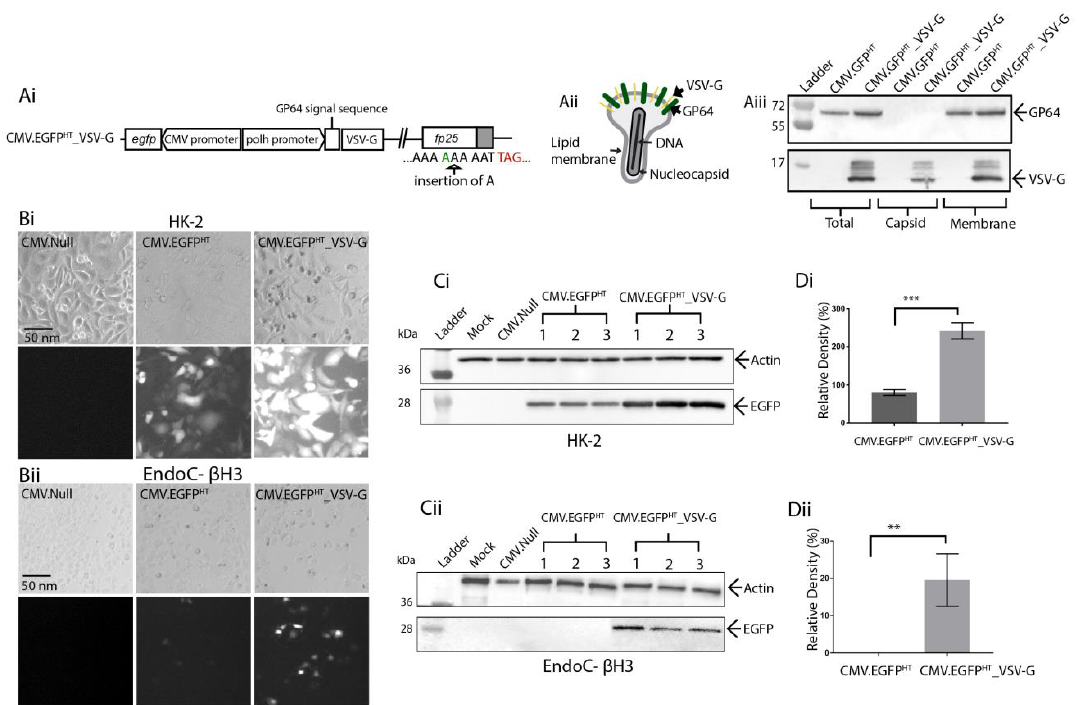
Figure 4. ( A ) schematic representation of the VSV-G pseudotyped BacMam vector construct. ( Ai ) 21-amino-acid ectodomain of VSV-G, with its transmembrane and cytoplasmic tail domains (aa 442–511) [29] was inserted into the HT virus genome under the control of the polh promoter as a fusion to the gp64 signal peptide. TAG, stop codon (red) ( Aii ) Schematic representation of the BV particle with VSV-G incorporation in the envelope surface alongside the native GP64 protein. ( Aiii ) immunoblot analysis of intact and fractionated BV (nucleocapsid and membrane envelope) were analysed by Western blotting using anti-VSV-G or anti-GP64 specific antibodies. Molecular weight markers are in kDa. ( B ) bright field and fluorescence images of ( Bi ) HK-2 (MOI 150) and ( Bii ) EndoC- β H3 (MOI 250) cells transduced with CMV.EGFP HT VSV-G pseudotyped or non-pseudotyped BacMam vectors. Images were taken at 72 hpt at 10 × using a Zeiss Axiovert 135 inverted epifluorescence microscope. Scale bar, 50 nm. ( C ) immunoblot analysis of transduced ( Ci ) HK-2 and ( Cii ) EndoC- β H3 cell lysates harvested at 72 hpt, using target-specific antibodies. B-actin was used as a loading control. Molecular weight markers in kDa; ( D ) a bar graph was constructed using GraphPad Prism showing the relative band intensities for EGFP in ( Di ) HK-2 and ( Dii ) EndoC- β H3 cells. Each sample was normalised against β -actin. Error bars represent ± SD (n = 3) and indicate a significant difference between CMV.EGFP HT and CMV.EGFP HT _VSV-G transduced cells as analysed using a Student’s t -test ( p < 0.05).